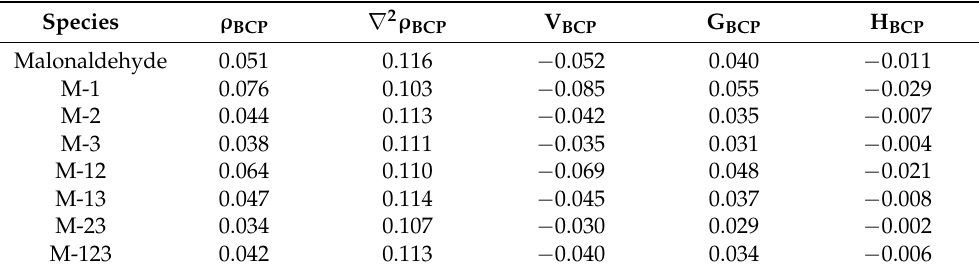
Table 2. Quantum Theory of ‘Atoms in Molecules’ (QTAIM) parameters, characteristics of the H ∙∙∙ O bond critical point (BCP) (in au) for malonaldehyde and its fluoro-derivatives (designations as in Table 1); ρ BCP —electron density at H ∙∙∙ O BCP, ∇ 2 ρ BCP —Laplacian of electron density, H BCP — total electron energy density at H ∙∙∙ O BCP, and its potential and kinetic components, V BCP and G BCP , respectively.